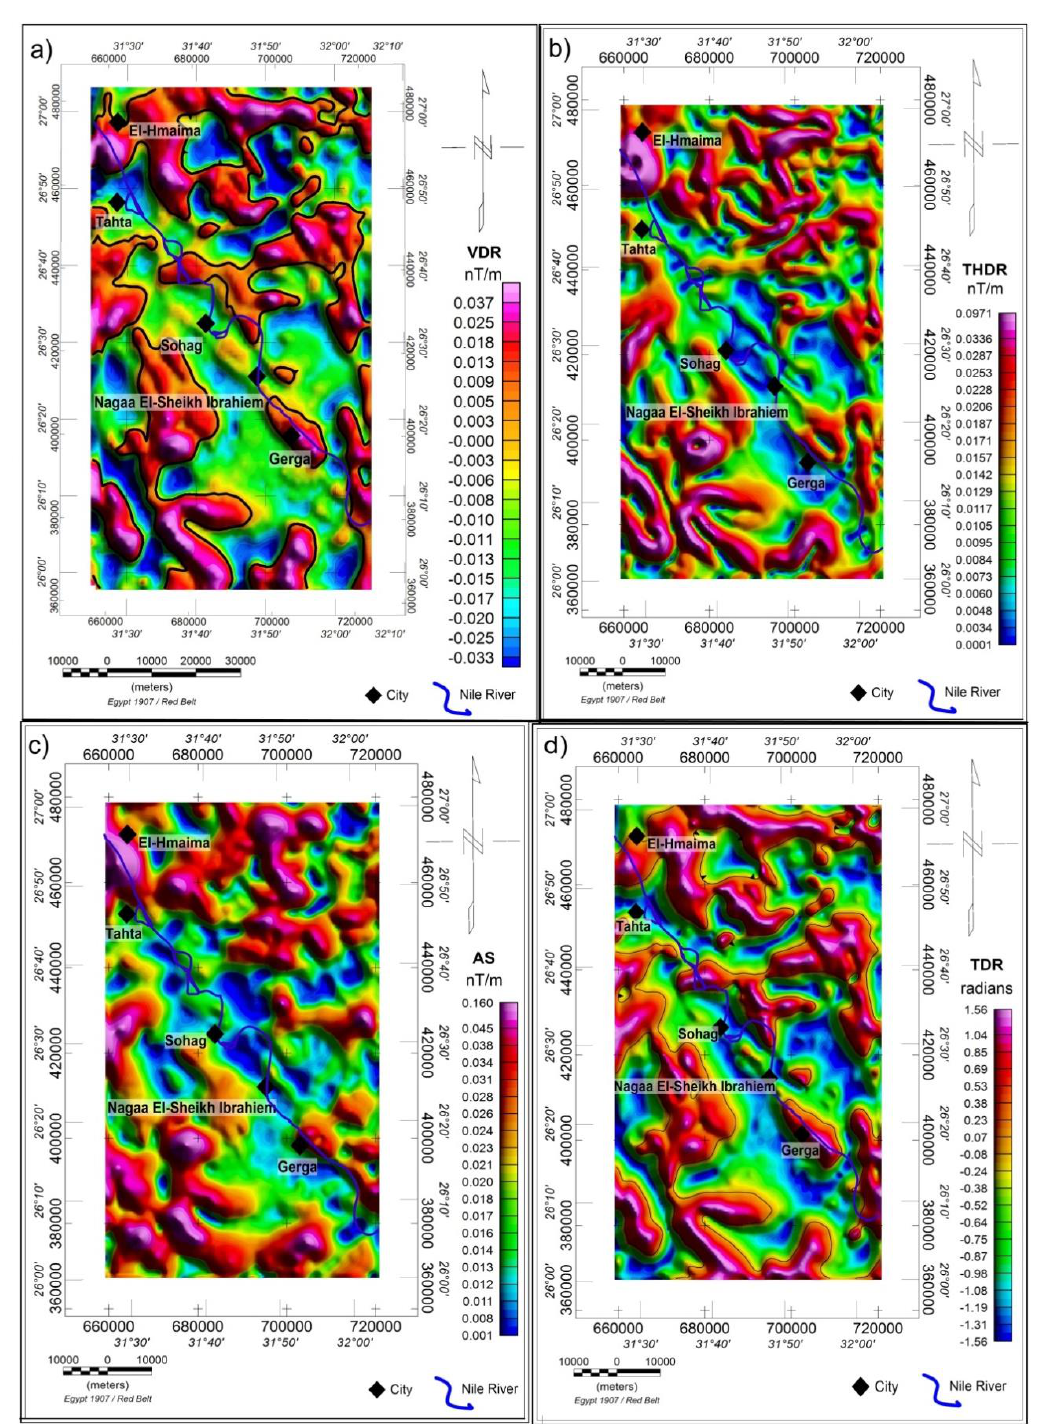
Figure 4. VDR ( a ), THDR ( b ), AS ( c ), and TDR ( d ) maps of the investigated area. The zero contour line is displayed on VDR and TDR maps to indicate the boundaries of causative magnetic sources.